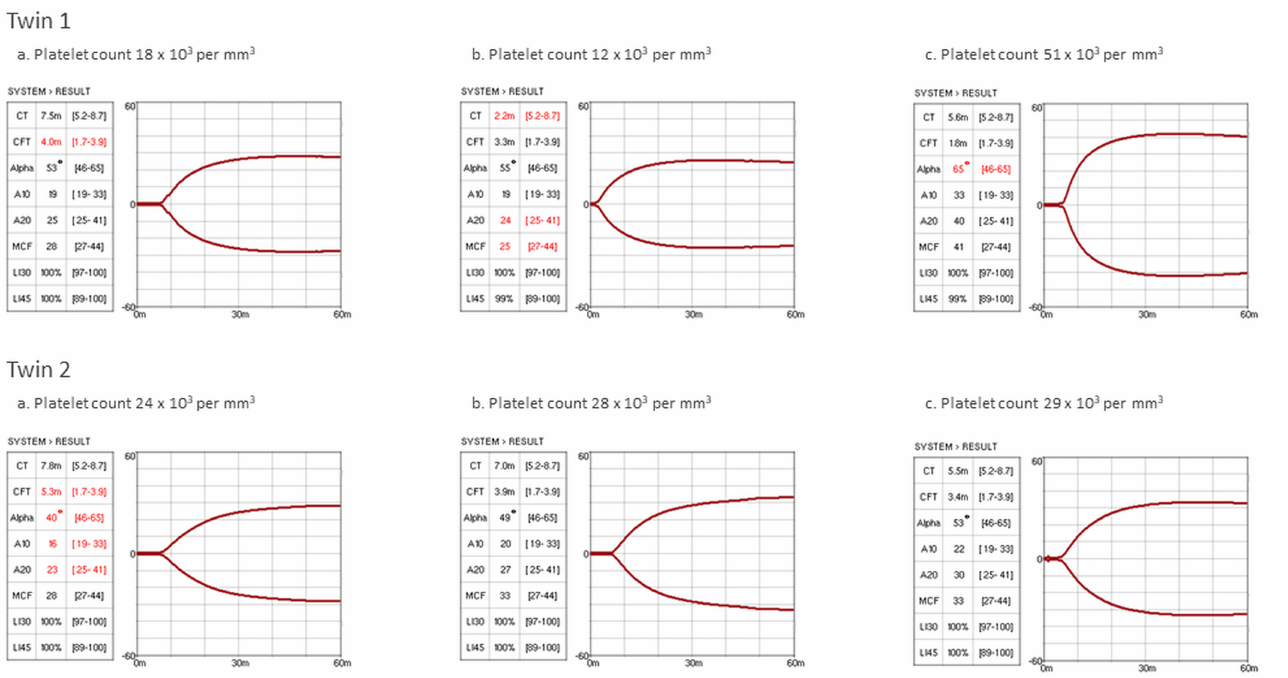
Figure 1. VCM © numerical results and graphic representation of patients’ hemostatic profiles. VCM © analysis showed competent hemostasis despite severe thrombocytopenia in both twins. For each patient, VCM © results and a corresponding platelet count performed at three consecutive times (day 1, day 3, and day 7 for both twins) during hospitalization are shown. CT, clotting time (min); CFT, clot formation time (min); alpha, alpha angle (degrees); A10 and A20, amplitude